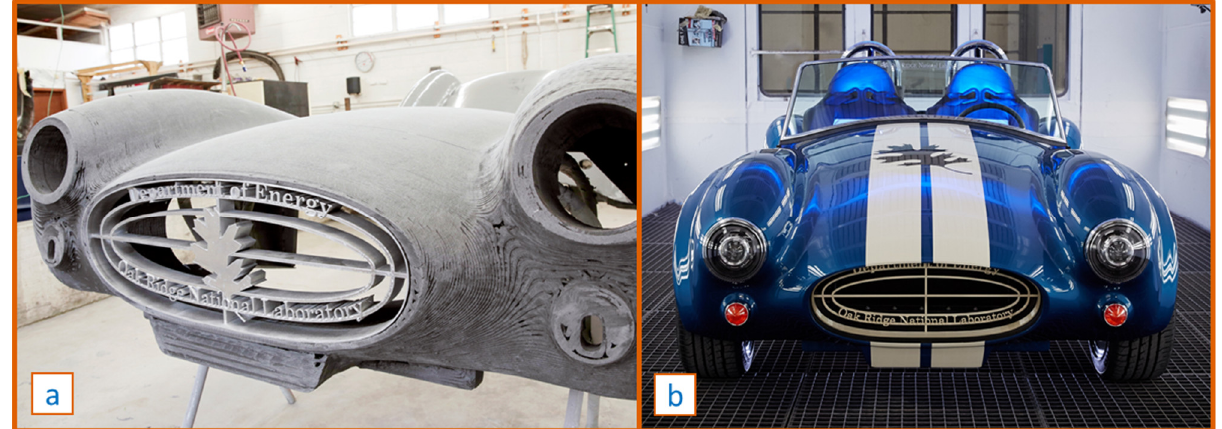
Figure 7. Composite spare-part reconstruction based on direct AM processes: the Shelby Cobra’s ( a ) rough and ( b ) finished bodywork (photo credits: Oak Ridge National Laboratory (ORNL)).